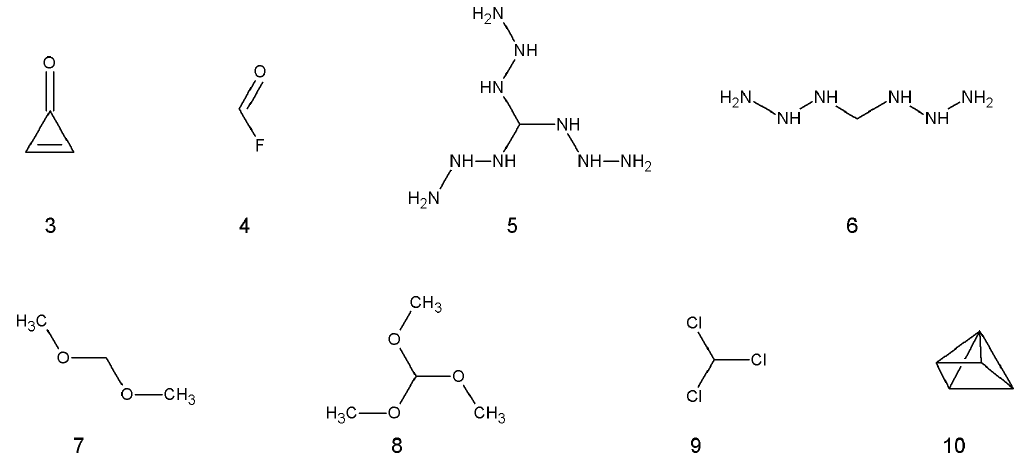
Figure 6. Chemical structures of the 8 molecules identified as outliers following linear regression. doi:10.1371/journal.pone.0111576.g006 PLOS ONE |